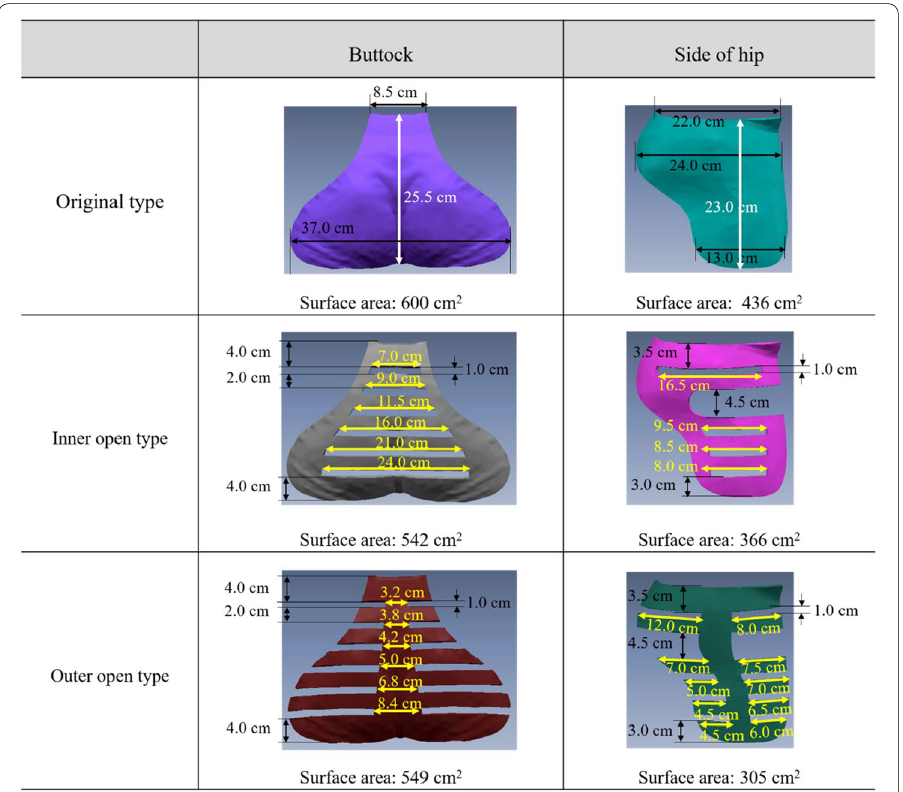
Fig. 3 Pad modeling sizes and incision shapes for hip